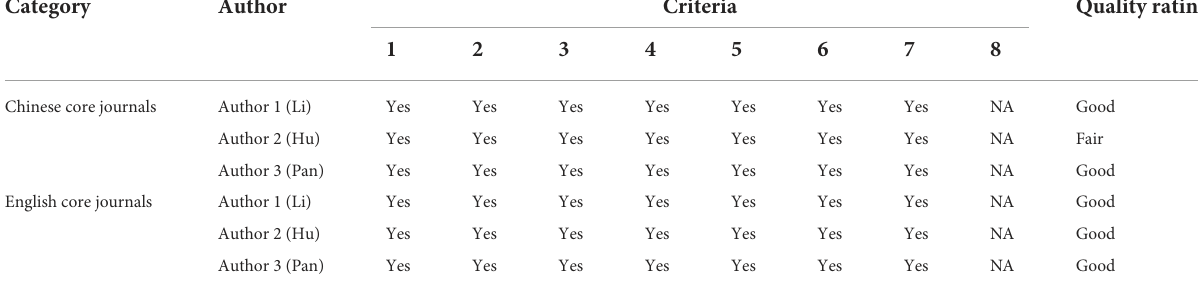
TABLE 1 Summary of quality assessment and risk of